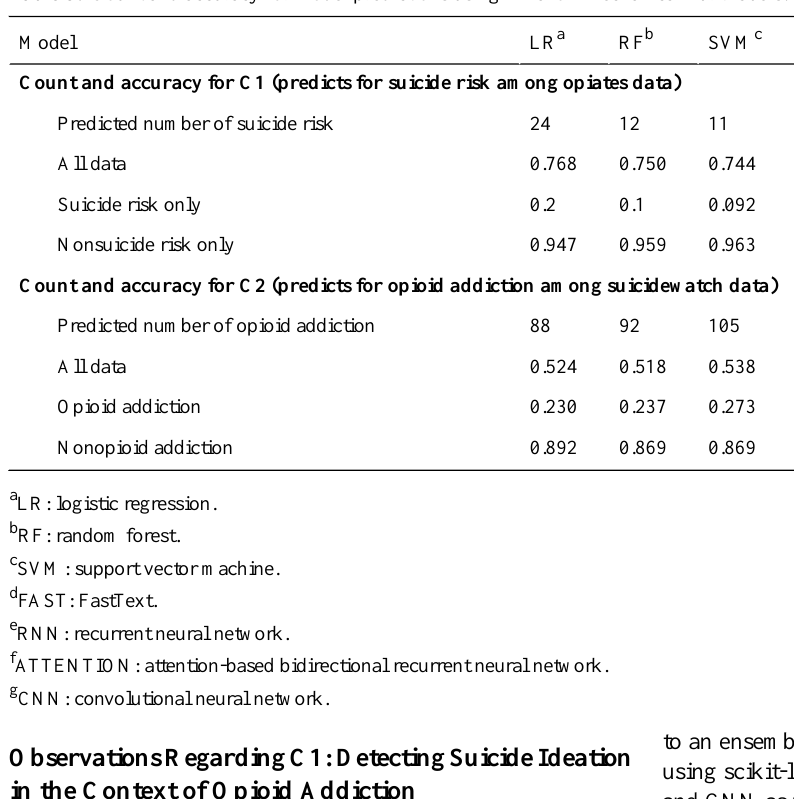
Table 5. Count and accuracy for model predictions using Amazon Mechanical Turk